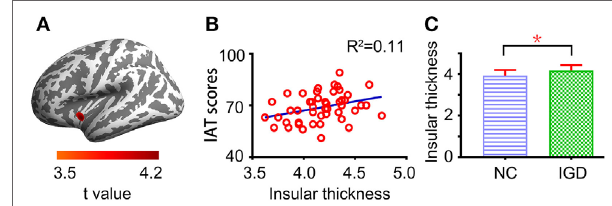
FigUre 2 | (a) The panel shows the left lateral brain image depicting a correlation between the left insular cortical thickness (CT) and Internet Addiction Test (IAT) total scores in male youths with Internet gaming disorder (IGD). The image was peak-level thresholded at P < 0.001 (two-tailed, uncorrected) and cluster-level thresholded at cluster size > 100 for exploratory analysis. The warm color denotes the positive correlation, and the colored bar shows t values. (B) The scatter plot shows the relationship between means of the left insular CT and IAT total scores in youths with IGD. R 2 , the coefficient of determination. (c) The histogram illustrates group means of the left insular CT for youths with IGD and normal controls (NCs).* P < 0.05. Error bars reflect the SD.